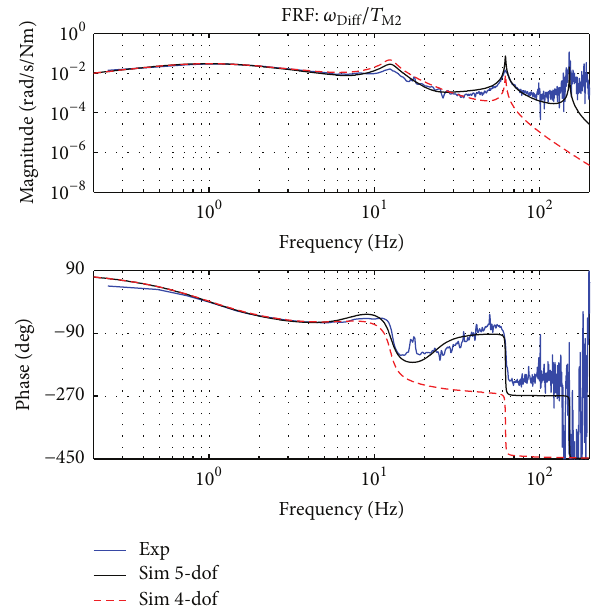
Figure 16: Tuning of the model order with the experimental